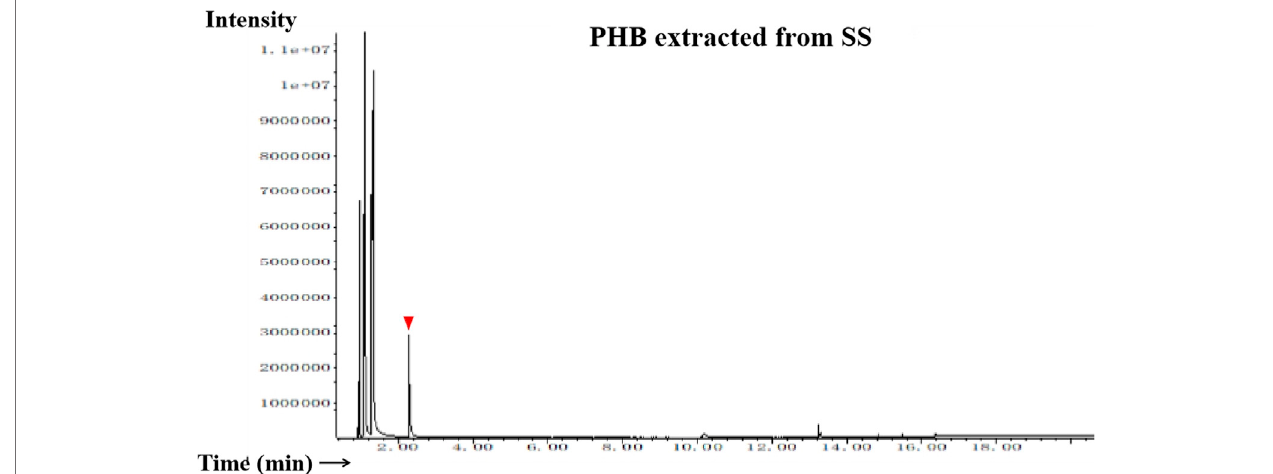
FIGURE 3 | Gas chromatogram of PHB extract from SS. Red triangle means the retention time.